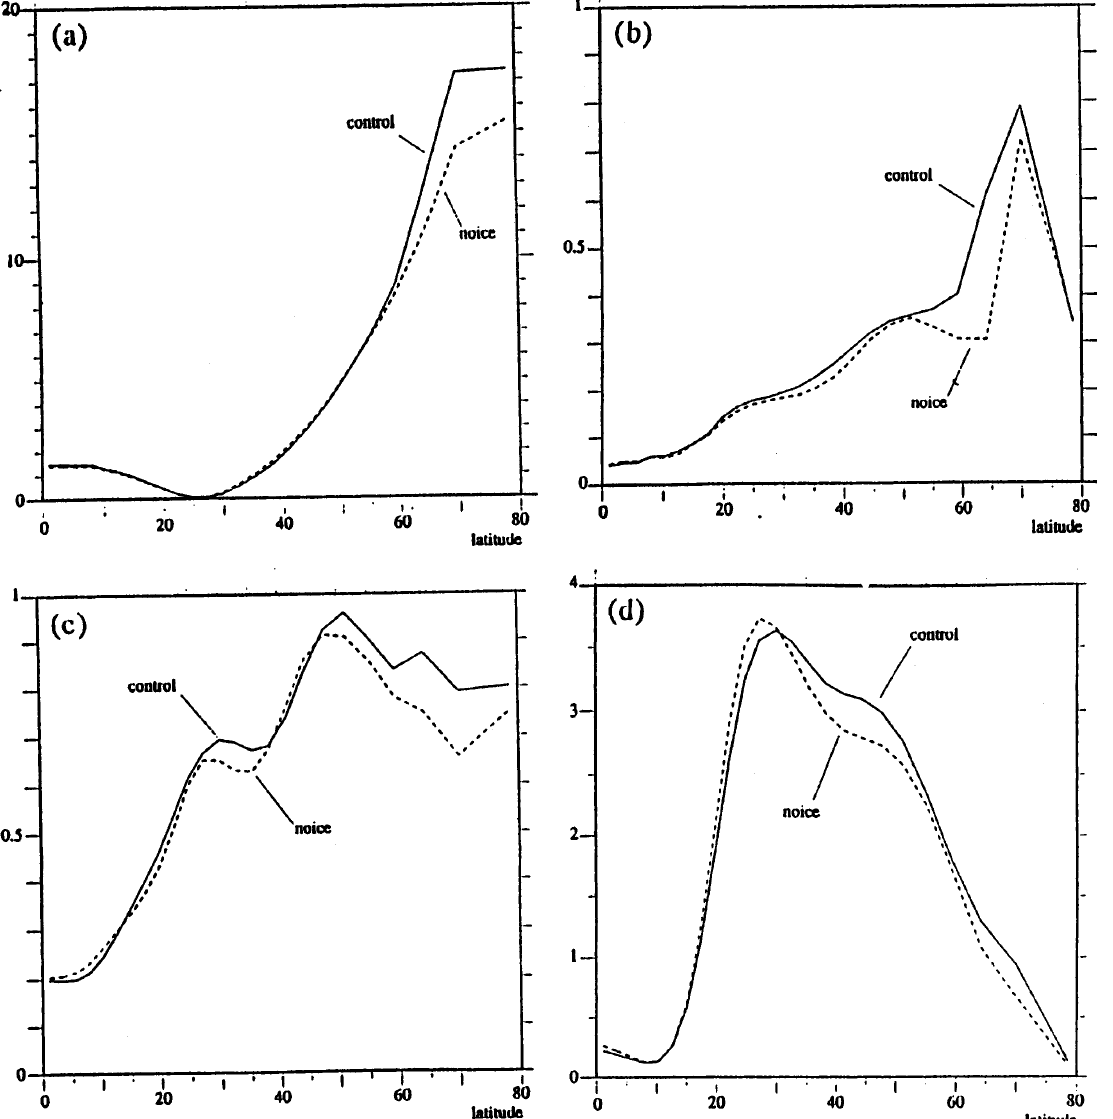
zonal flow, b available potential energy of the perturbations, c kinetic energy of the perturbations, and d kinetic energy of the mean